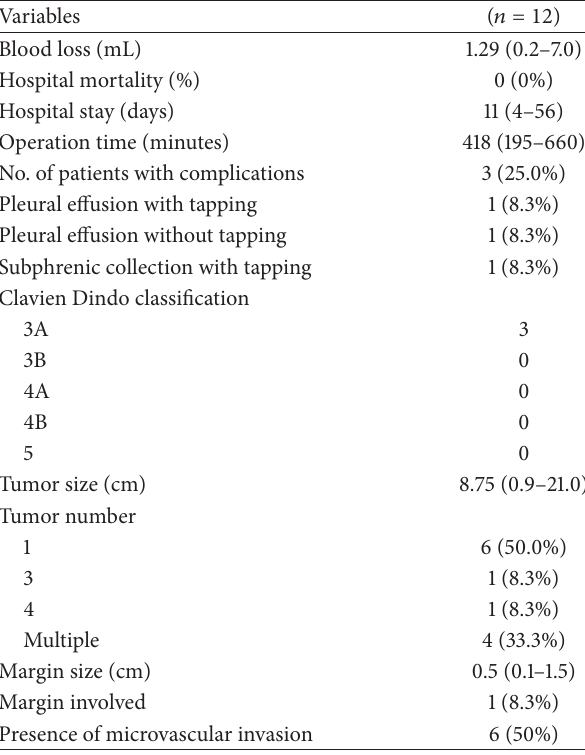
Table 2: Operations details of liver resections for NELM.